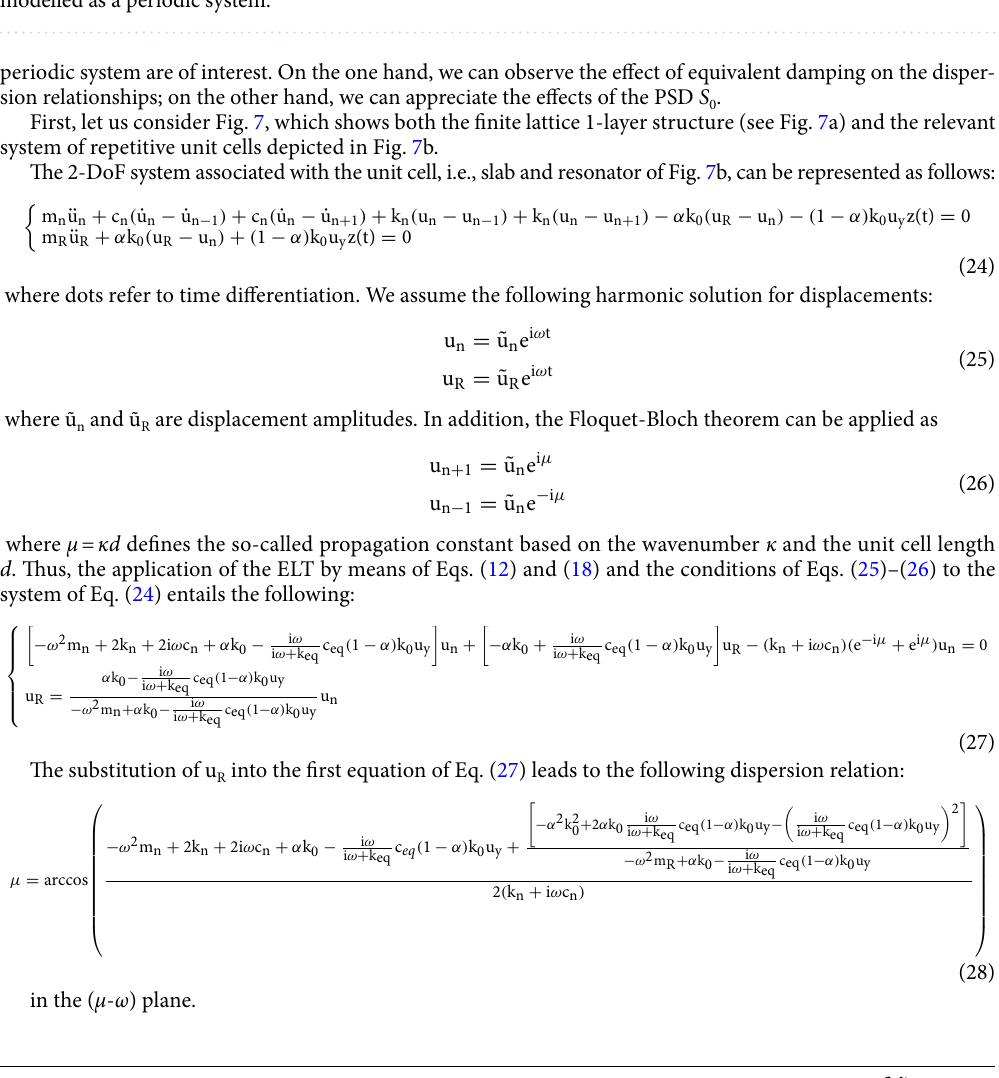
Figure 7. Dynamic systems: ( a ) coupled finite lattice metafoundation-tank system; ( b ) metafoundation modelled as a periodic